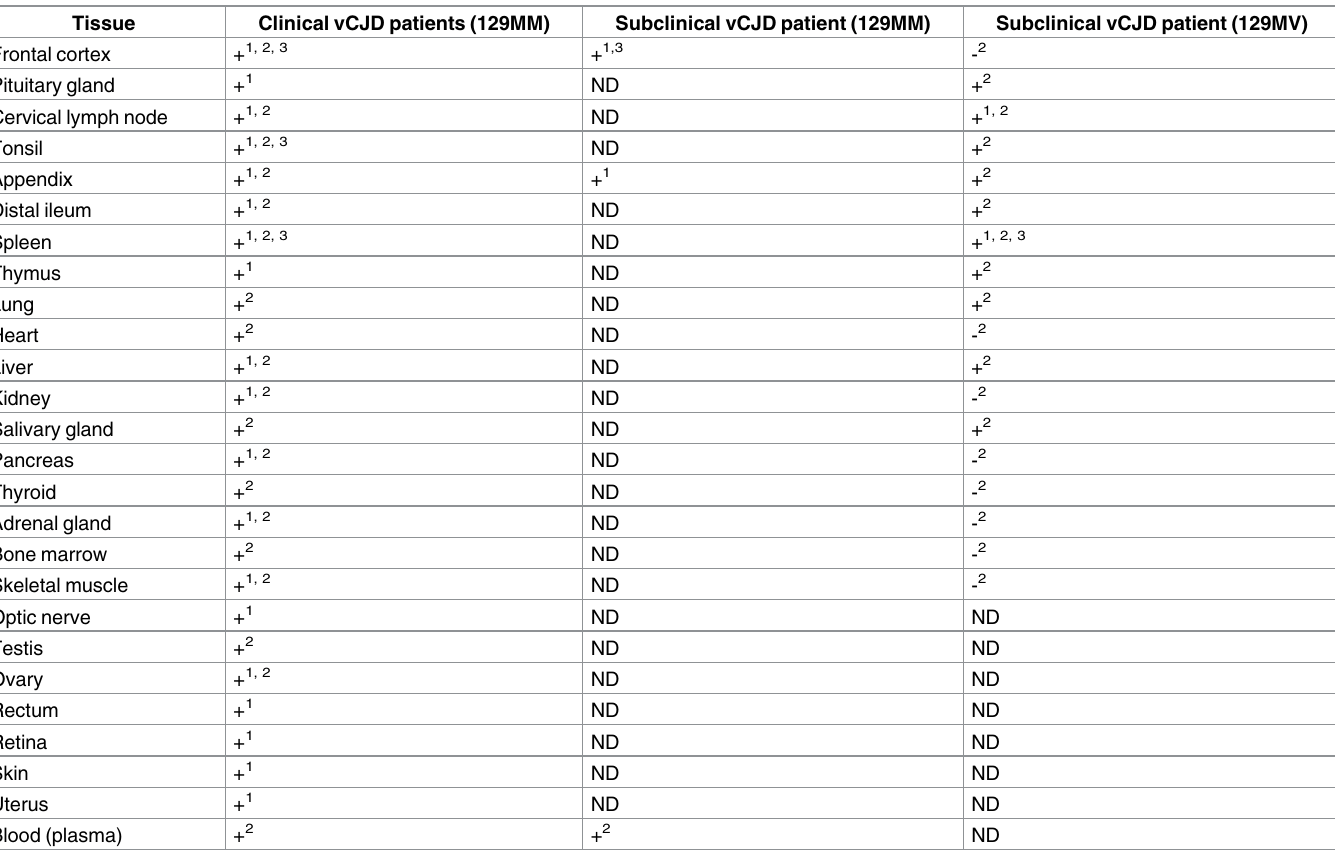
Table 1. Tissues identified as containing abnormal PrP and/or infectivity in clinical and subclinical vCJD patients.